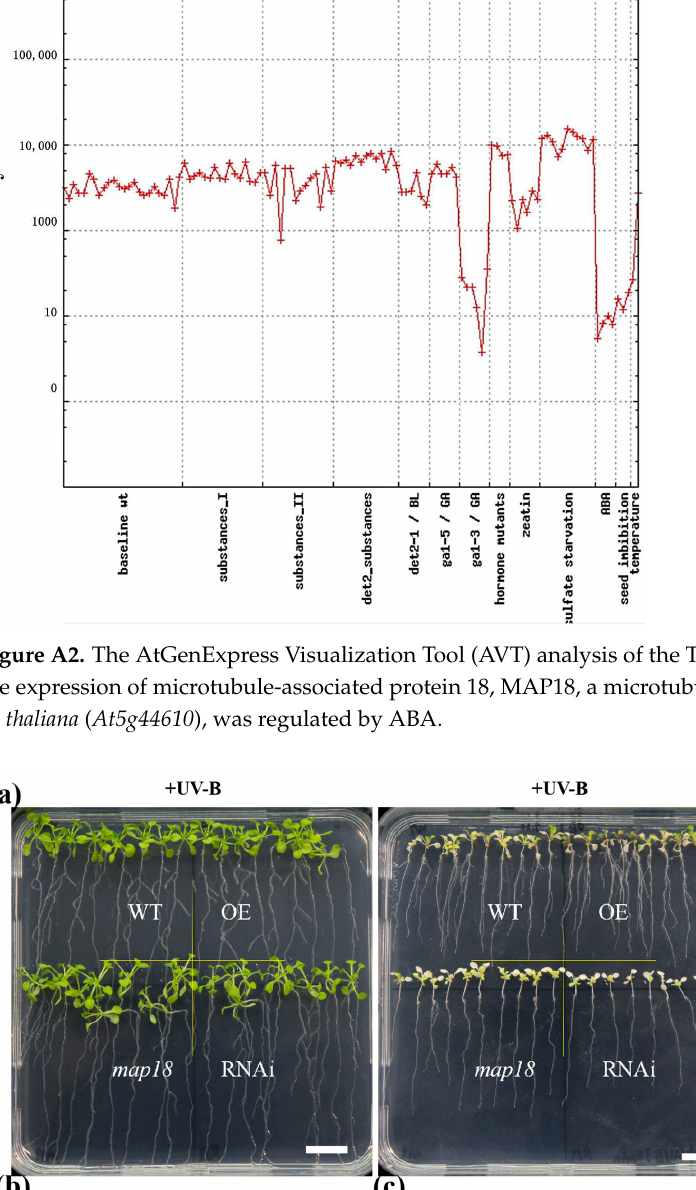
Figure A1. Phenotype screening of Col-0 A. thaliana seedlings responding to different duration of UV-B radiation to determine that 30 min of 90 mJ cm − 2 of UV-B radiation was selected for this study. Scale bars represent 1 cm.